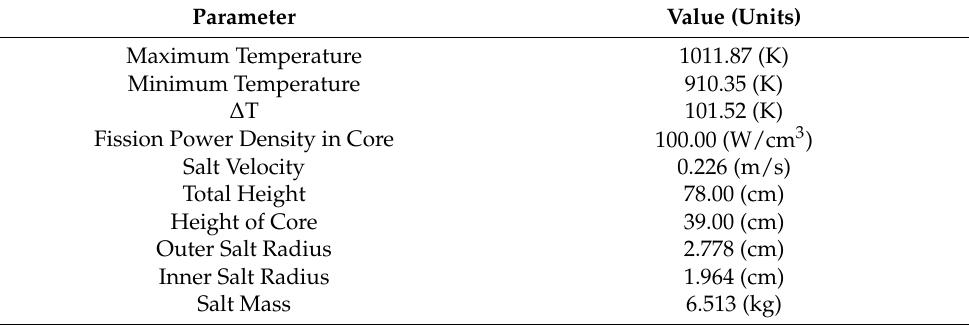
Table 1. VESIL parameters [7].